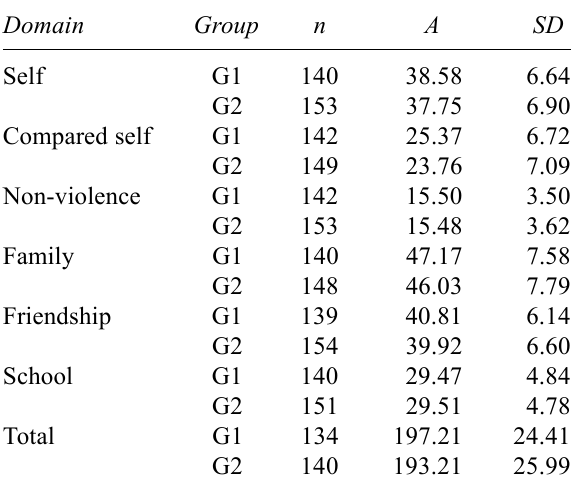
Means, Standard Deviations, and n per Development Context of the Multidimensional Life Satisfaction Scale Domains